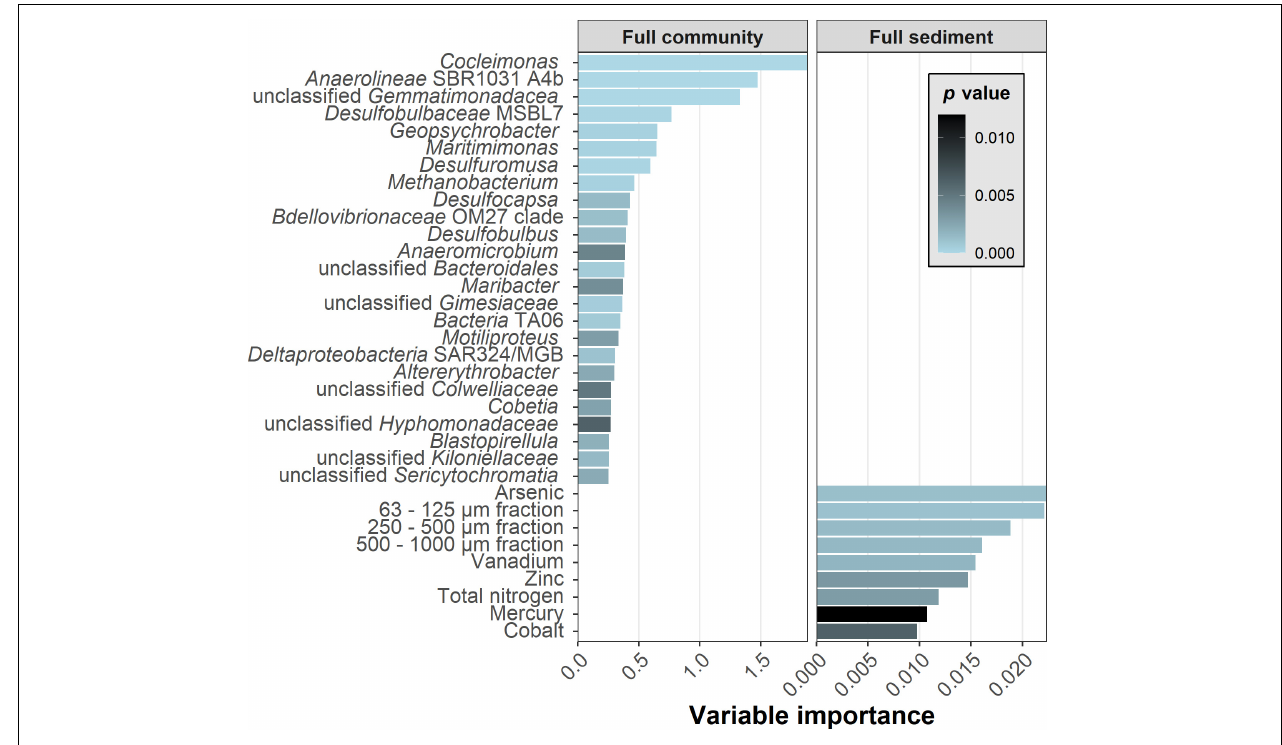
FIGURE 5 | The variable importance and p -values for the classification of TNT presence. Twenty-five genera of the Full community and nine sediment parameters of Full sediment were selected. The most detailed taxonomic annotation was provided in case none was available at genus rank. Importance and p -values were generated after Altmann (Full sediment) and Janitza (Full community) for six data splits and subsequently